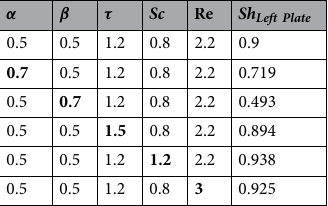
Table 4. Sherwood number variation against different